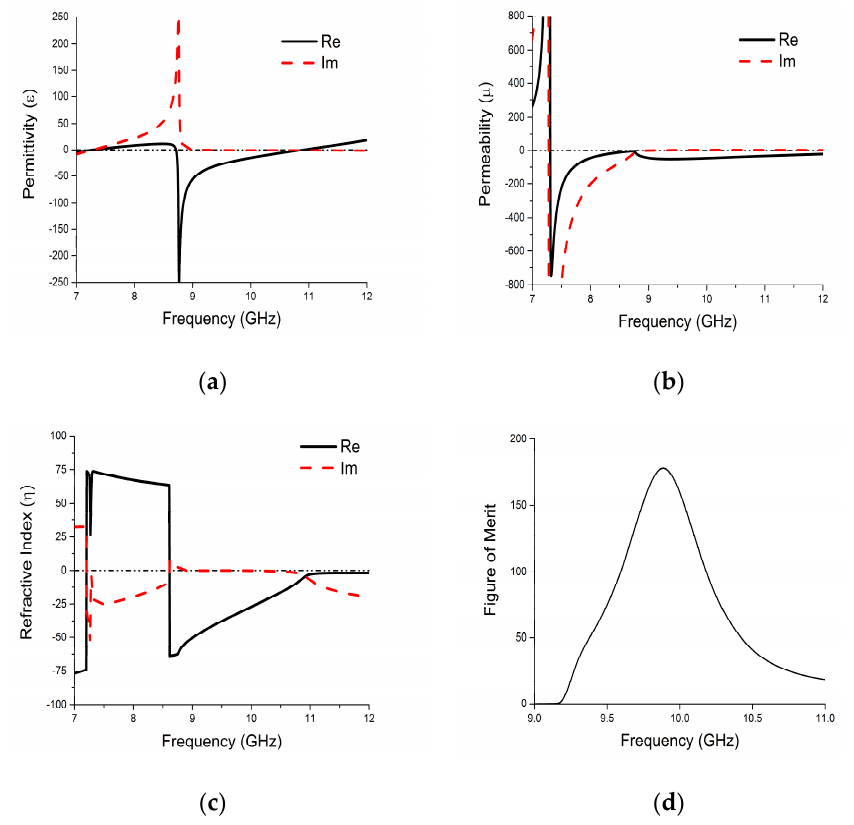
Figure 7. Extracted effective parameters: ( a ) effective permittivity; ( b ) effective permeability; ( c ) index of refraction; ( d ) figure of merit.